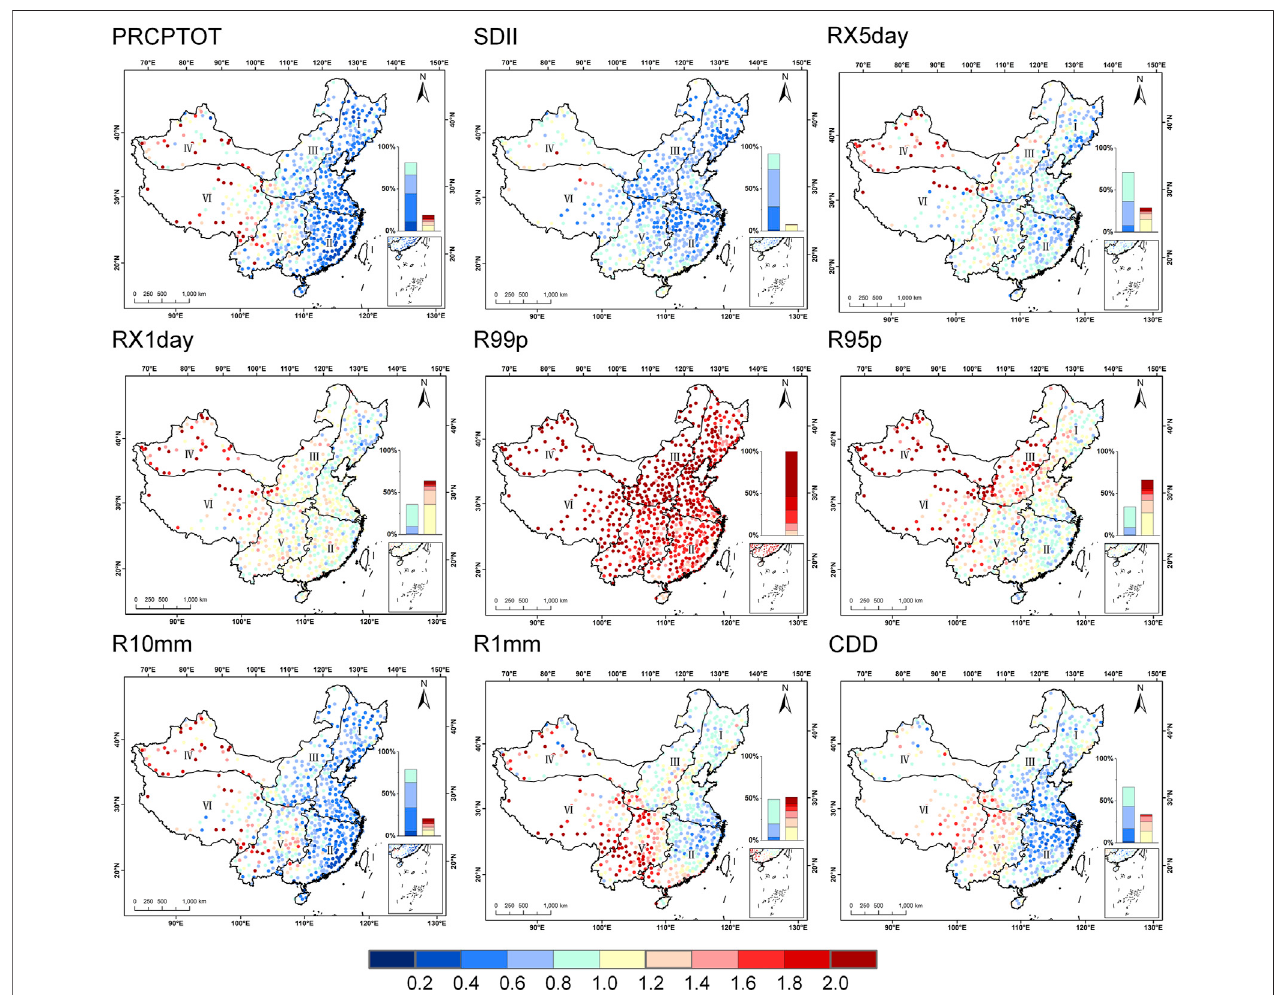
FIGURE 3 | Spatial distribution of DISO for extreme precipitation indices of ERA5 over